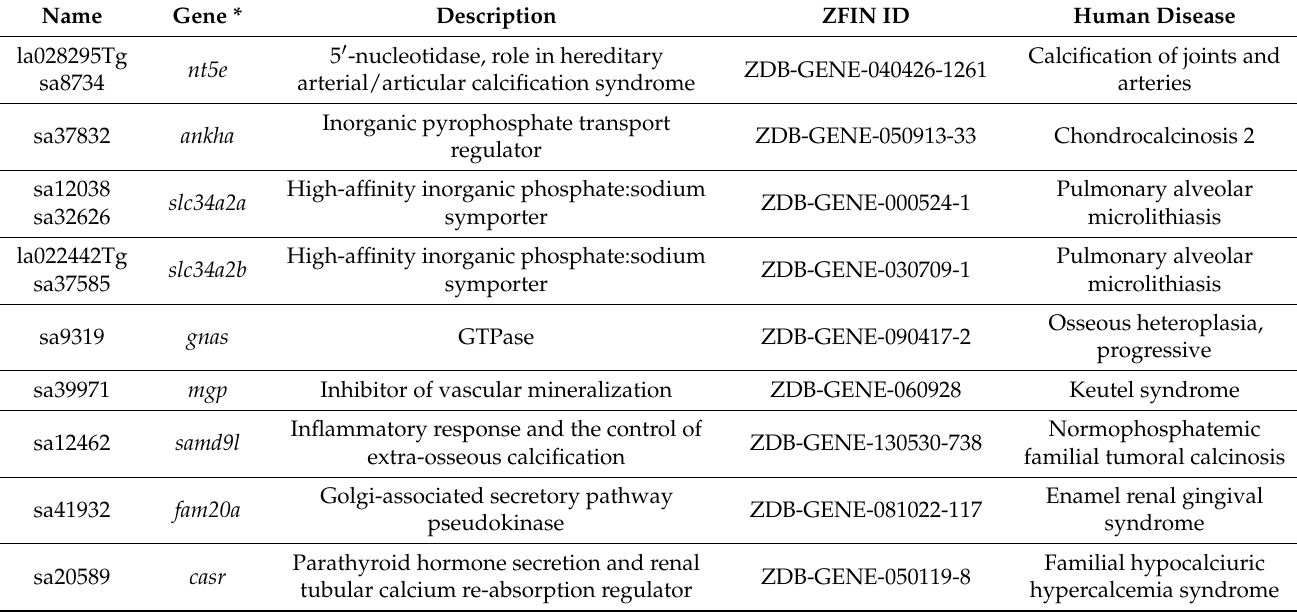
Table 2. Zebrafish mutants yet to be